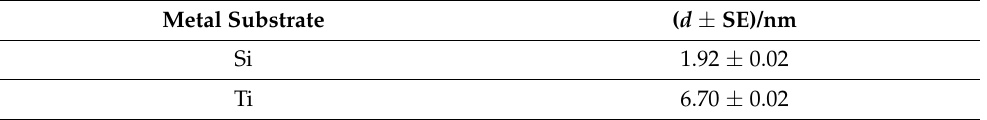
Table 1. Values of the oxide layer thickness ( d ) on silicon and titanium surface with the corresponding standard errors determined ellipsometrically as the average of the 10 measurements at various locations on the surface.